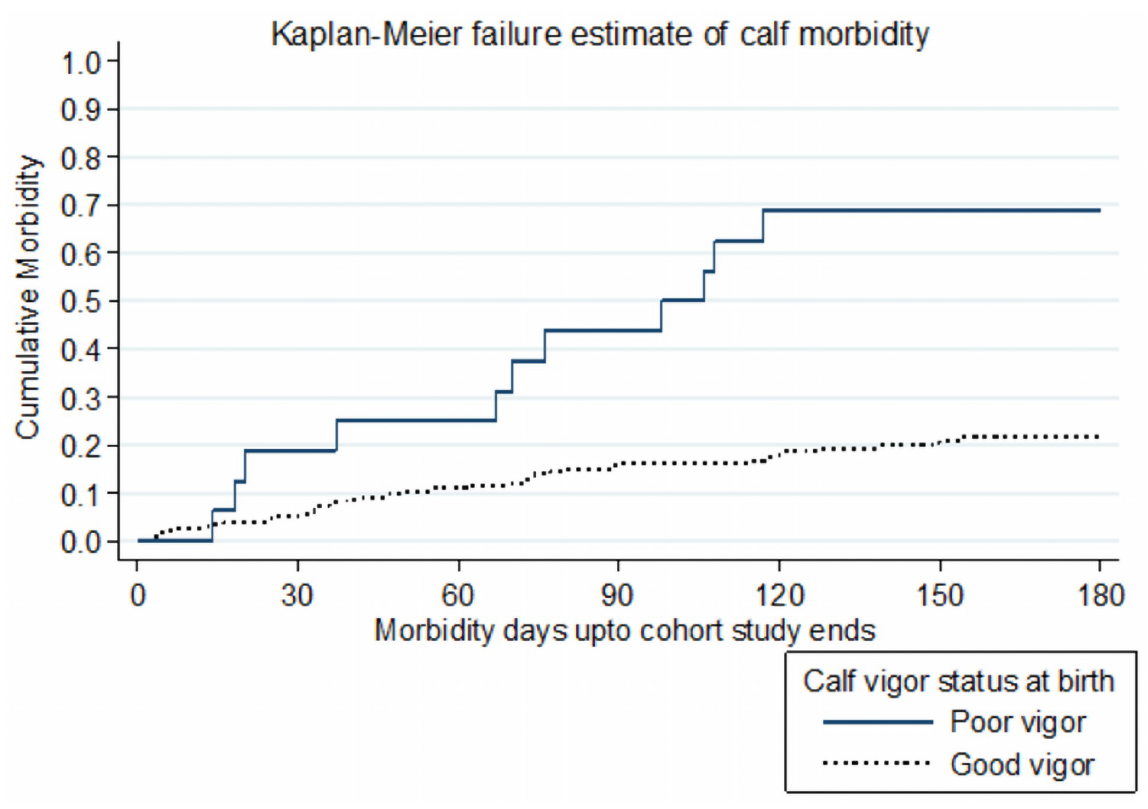
Fig 5. Calf morbidity compared by calf vigor status at birth factor.